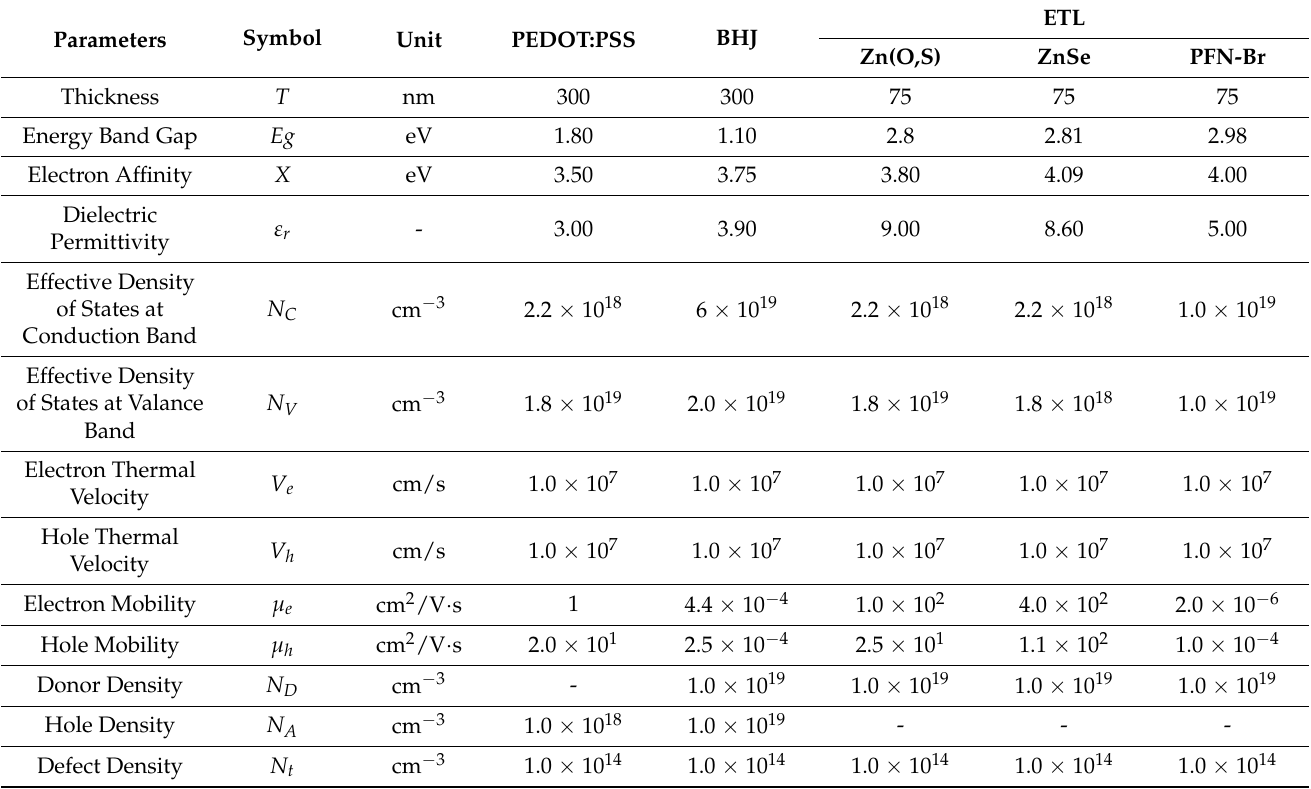
Table 1. The physical and material parameters of the active BHJ, hole transport, and electron transport layers used in the simulation, as required by